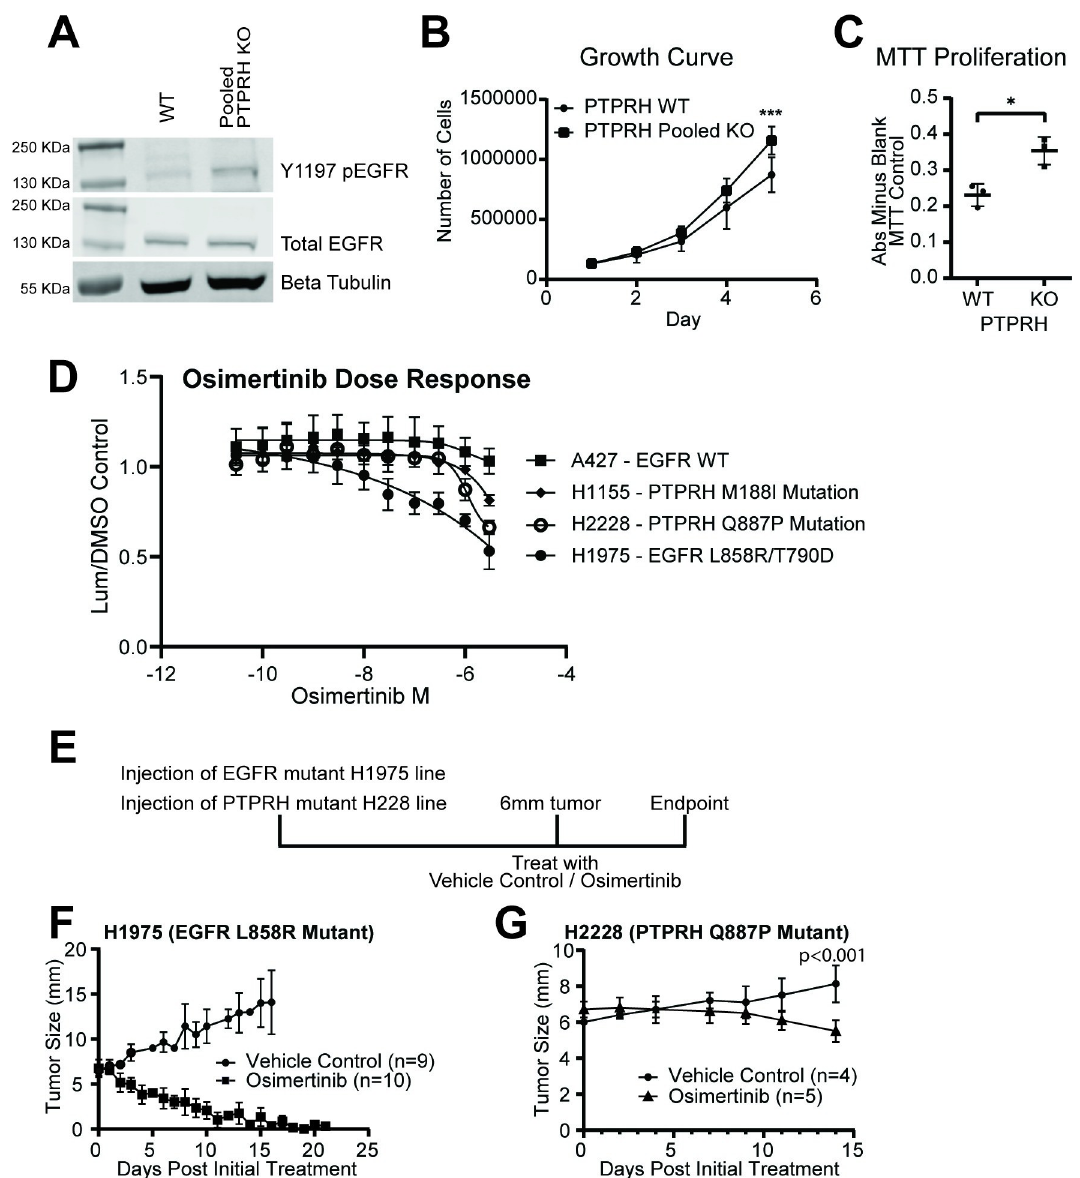
Fig 4. PTPRH mutant cell lines respond to TKI osimertinib. Pooled PTPRH KO cells have increased proliferation, and PTPRH mutant cell lines respond to osimertinib. A) Western blotting confirms increased p-EGFR at tyrosine 1197 within pooled KO cells compared to WT cells. B) Cellular growth curves show increased growth in PTPRH pooled KO cells as compared to WT cells. C) MTT assays completed with H23 WT and H23 PTPRH pooled KO cells show increased proliferation. D) Two PTPRH mutant cell lines (WT for EGFR) from human non-small cell lung cancer tumors show response to the TKI osimertinib in vitro . E) Treatment plan for in vivo treatment of H2228 PTPRH mutant cell line. Either H1975 (L858R EGFR mutant) or H2228 (Q887P PTPRH mutant) cells were injected into the left flank of nude mice. Mice were then randomized into two treatment groups, vehicle control or osimertinib. H1975 mice were treated with 25 mg/kg of osimertinib and H2228 injected mice were treated with either 25 mg/kg or 50 mg/kg of osimertinib. F) in vivo drug curve showing response to osimertinib of H1975 EGFR mutant injected mice. G) in vivo drug curve showing response to osimertinib of H2228 PTPRH mutant injected mice.